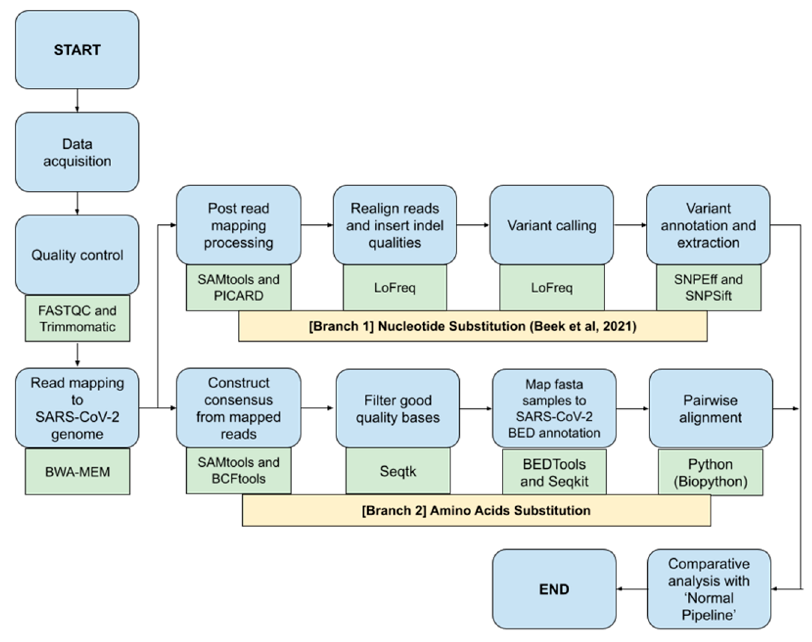
Figure 1. Fast Pipeline scheme; blue shapes represent the method; green shapes represent the tools used in each phase.